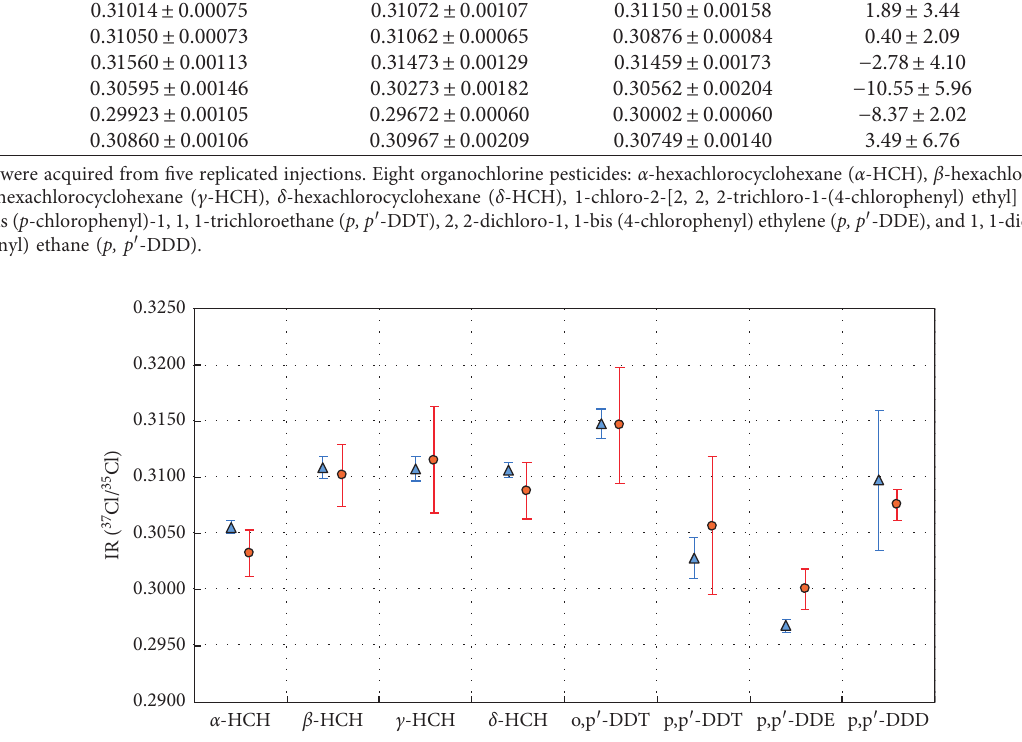
Figure 8: IR ( 37 Cl/ 35 Cl) values for standards from Supelco (blue) and O2si (red). For each compound, the bigger error bars denote three times maximum standard deviations and the smaller ones denote one time minimum standard deviations, respectively. Eight or- ganochlorine pesticides: α -hexachlorocyclohexane ( α -HCH), β -hexachlorocyclohexane ( β -HCH), c -hexachlorocyclohexane ( c -HCH), δ -hexachlorocyclohexane ( δ -HCH), 1-chloro-2-[2, 2, 2-trichloro-1-(4-chlorophenyl) ethyl] benzol (o, p ′ -DDT), 2, 2-bis ( p -chlor- ophenyl)-1, 1, 1-trichloroethane ( p , p ′ -DDT), 2, 2-dichloro-1, 1-bis (4-chlorophenyl) ethylene ( p , p ′ -DDE), and 1, 1-dichloro-2, 2-bis ( p - chlorophenyl) ethane ( p , p ′